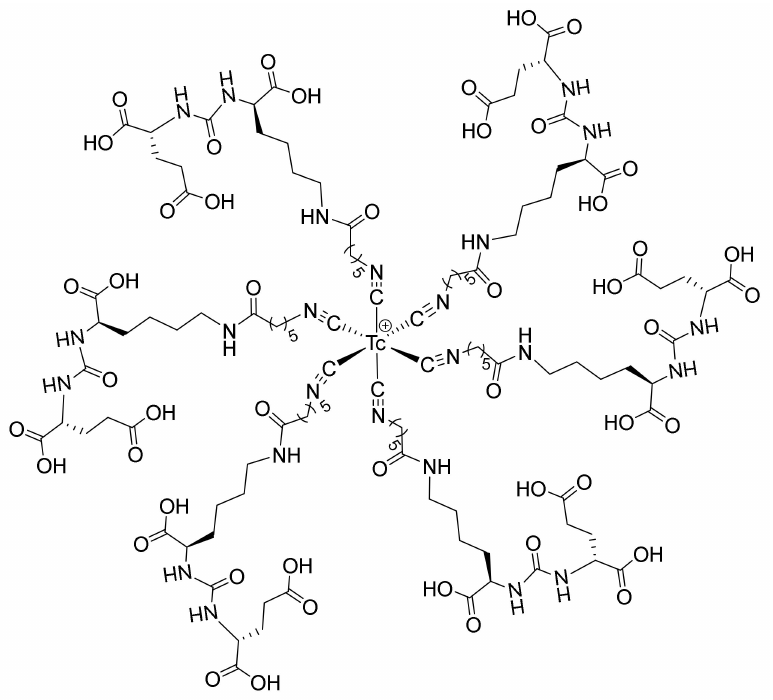
Figure 1. The proposed structure of [ 99m Tc]Tc-CNGU.